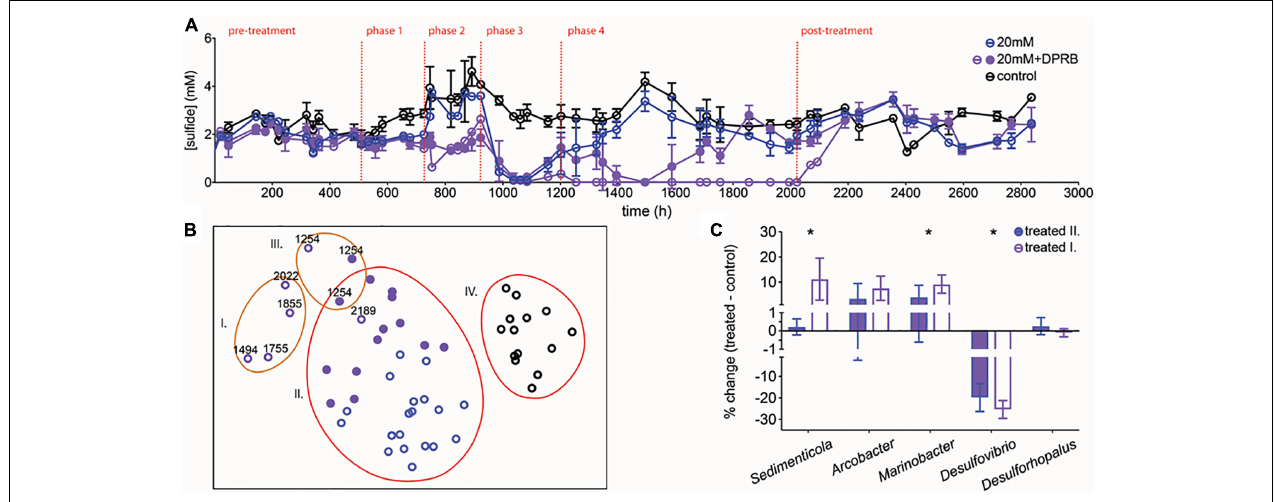
FIGURE 6 | (A) Average sulfide production in control chemostats (black circles), chemostats with 20 mM perchlorate (blue circles) and chemostats with 20 mM perchlorate, amended with DPRB (purple circles). Amended chemostats did not replicate each other and hence the two trajectories are shown as closed circles (replicates 1 and 2) and open circles (replicate 3). Dashed lines indicate start/stop of various treatments (refer to main text). Error bars represent SD for replicates. (B) nMDS plot of normalized and transformed 16S amplicon community profiles for control (black circles) and treated (20 mM: blue circles, 20 mM+DPRB: purple circles; open circles represent replicate 3) communities, during phase 4. Orange and red lines group samples at 65 and 70% similarity, respectively. Stress value of 0.2. Numbers next to symbols represent time (h) for sample. (C) % change in DPRB and SRM between groupings I or II and the control group IV. Grouping I represents samples from replicate 3 (the inhibited 20 mM + DPRB chemostat); grouping II represents samples from 20 mM perchlorate chemostats and replicates 1 and 2 of the 20 mM + DPRB chemostats. Groupings were defined based on % similarity as outlined in the nMDS plot (orange and red circles in B ). Error bars represent SD. ∗ Genera which differ significantly via ANOVA ( p < 0.01) between groupings I. and II.